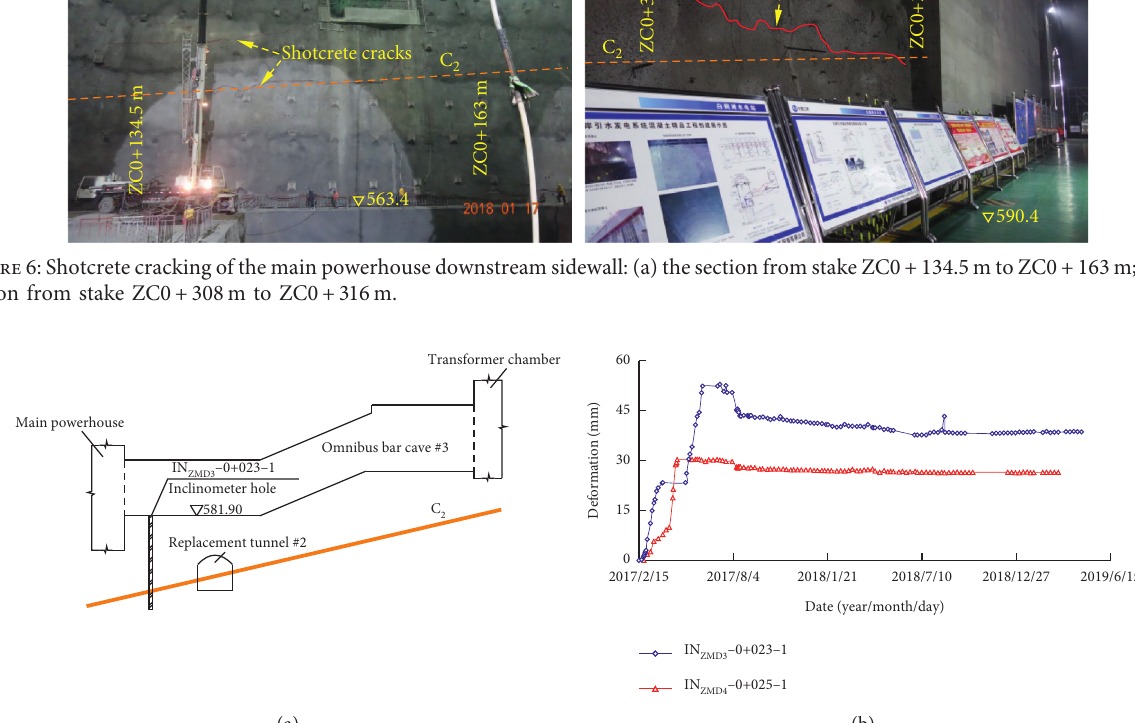
ZMD4 refers to omnibus bar cave #4 and 0+025-1